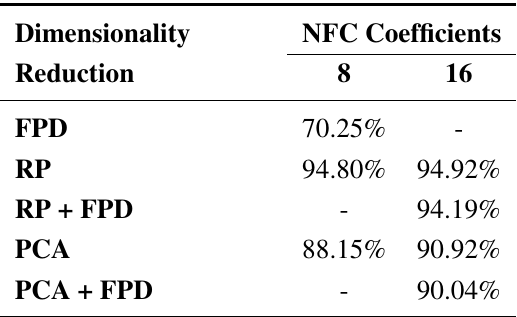
Table 2. Average Normal Discard Rate (NDR) in the 4-fold cross validation process for a fixed minimum Abnormal Recognition Rate (ARR) of 95%.